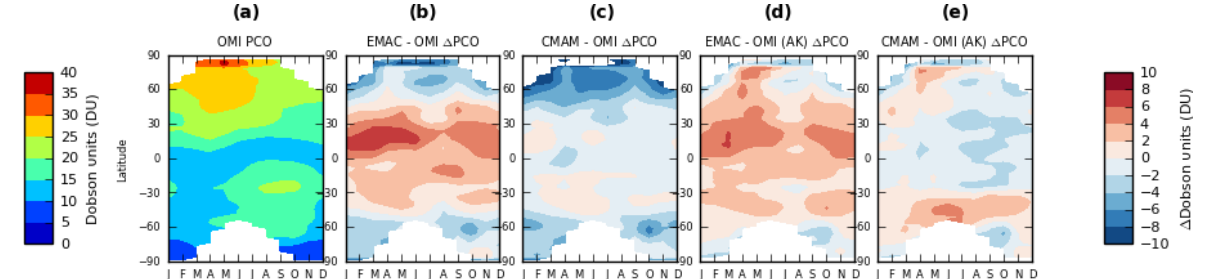
Figure 2. Zonal-mean monthly averaged 1000–450hPa (0–5.5km) sub-column O 3 (DU) for 2005–2010 from (a) OMI, (b) EMAC minus OMI without AKs, (c) CMAM minus OMI without AKs, (d) EMAC minus OMI with AKs and (e) CMAM minus OMI with